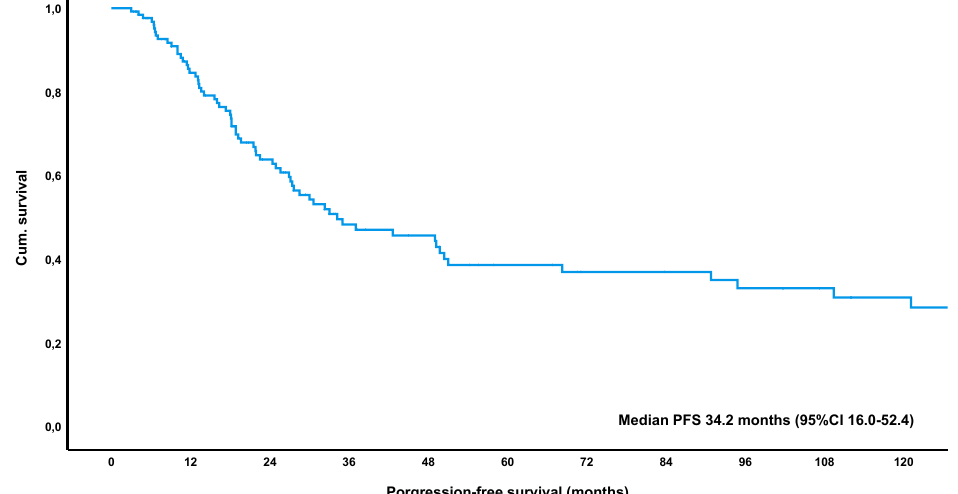
Porgression-free survival (months) Figure 1. Kaplan-Meier curve for progression-free survival following first-line treatment for patients with gastric mucosa-associated lymphoid tissue (MALT) lymphoma. Abbreviations: CI = confidence interval.